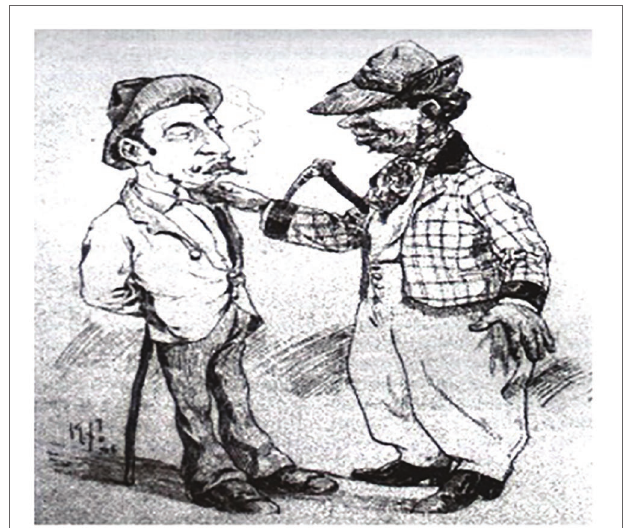
FIGURE 1 | Types and